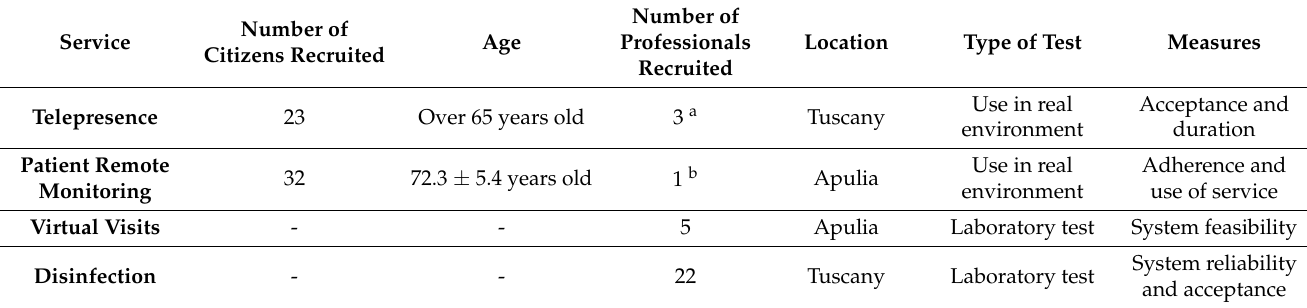
Figure 3. ( a ) Ohmni robot and professional caregiver during the telepresence service in a residen- tial facility; ( b ) user interface developed for the virtual visit service; ( c ) disinfection robot and its main components. Table 2. Summary of the recruited participants in each pilot